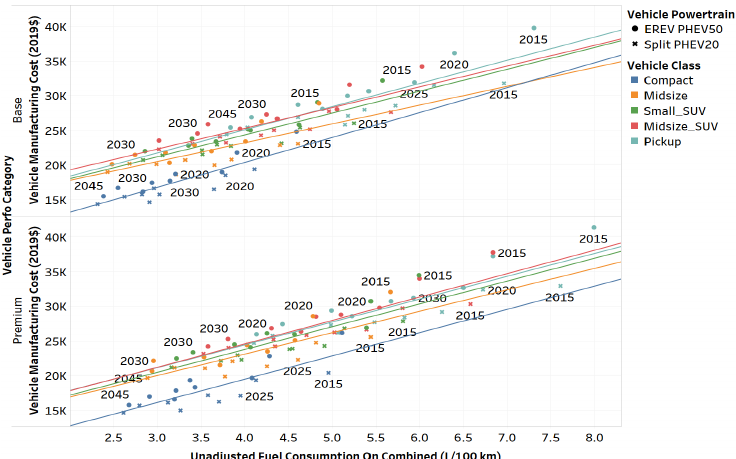
Figure 16. Manufacturing cost versus fuel consumption of PHEVs.